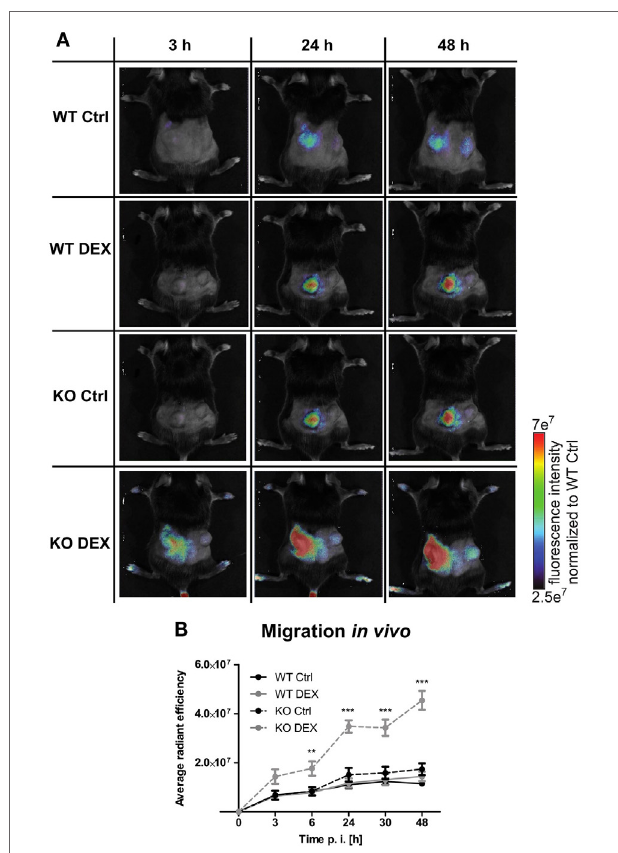
FigUre 8 | Increased migration in dexamethasone (DEX)-treated peroxisome proliferator-activated receptor- γ -deficient cells in vivo . (a,B) On day 3 of differentiation, ER-Hoxb8 cells were treated with DEX (100 nM) for 48 h. In parallel, a cutaneous granuloma model (CG) was established by subcutaneous injection of BioGel/LPS (left plug) or BioGel only (right plug) at the dorsal flank region of mice. 24 h later cells were labeled with the fluorescent dye DiD and injected in the tail vein of mice. Migration was tracked at 3, 6, 24, 30, and 48 p.i. by fluorescence reflectance imaging (FRI) using IVIS Spectrum. (a) Images show the results from one representative experiment. (B) The bars represent the mean with the SEM of five mice of two independent experiments (** p < 0.01, *** p < 0.001) (calculated by using two-way